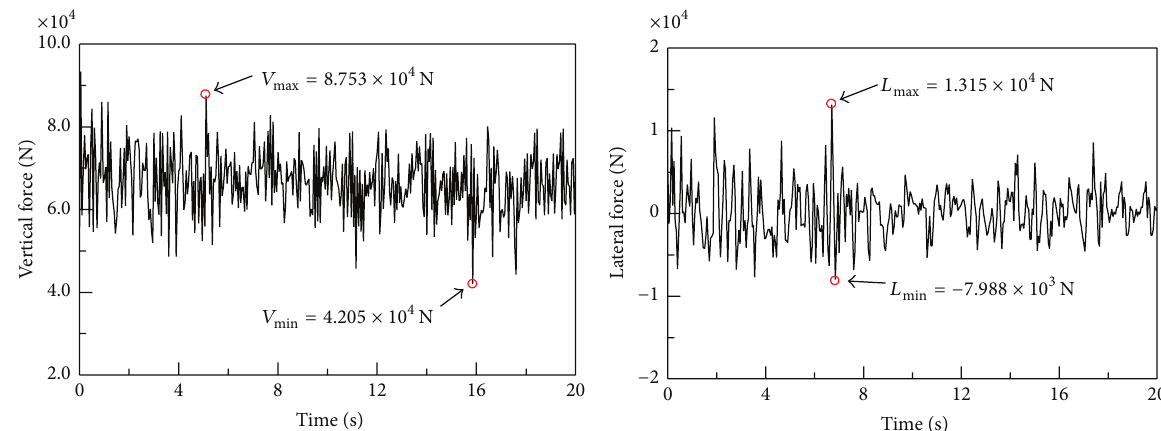
Figure 14: Time histories of vertical and lateral wheel-rail force of the first wheel set without earthquake.